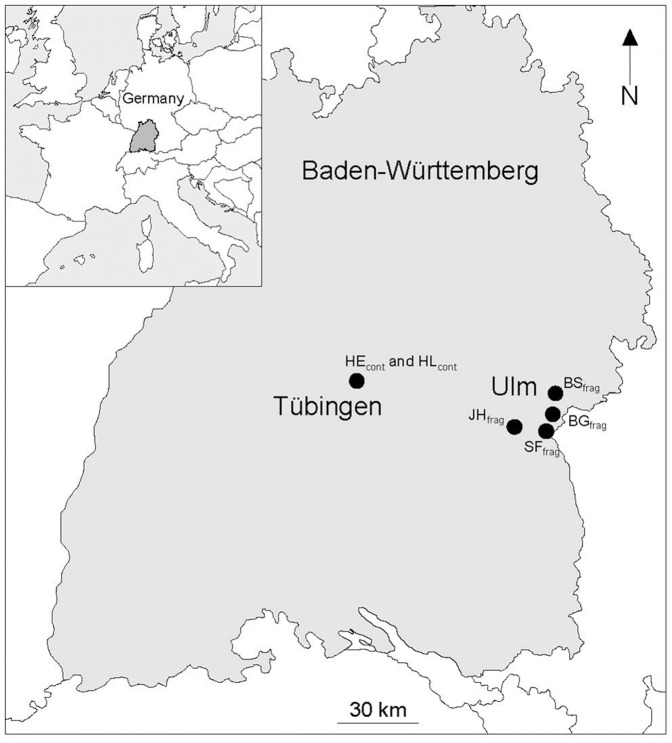
Map of Baden-Württemberg (Germany) showing the positions of the study sites at two locations.See Table 1 for detailed information. Insert shows the map of Europe with Baden-Württemberg in dark grey.